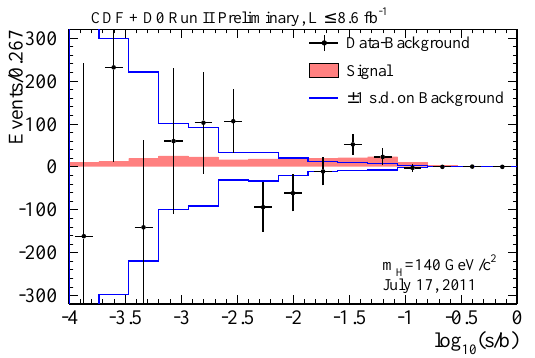
Fig. 2. Background-subtracted distributions of lo g 10 ( s / b ) for the data from all contributing channels from the combined CDF and D0 analyses for m H = 140 GeV / c 2 .